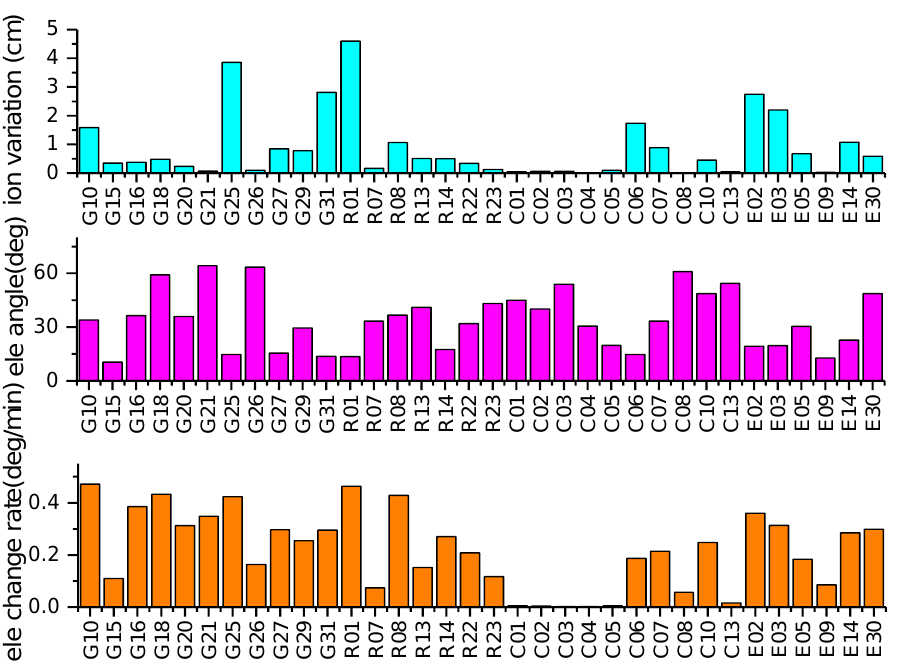
Figure 12. Average 15 s latency variation of ionosphere error (top), elevation angle (middle), and the change rate of elevation angle (bottom) in Session A2.